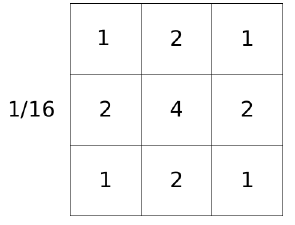
Figure 5. Gaussian mask for kernel size